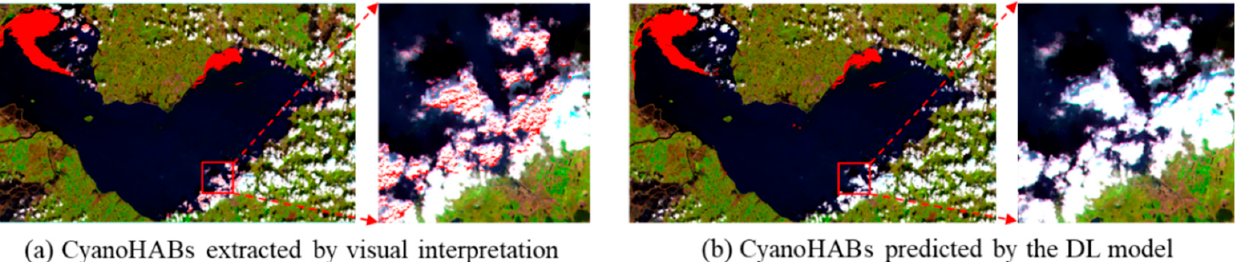
Figure 14. Sensitivity of the DL-based CyanoHABs prediction model to cloud (red indicates the extracted CyanoHABs area).